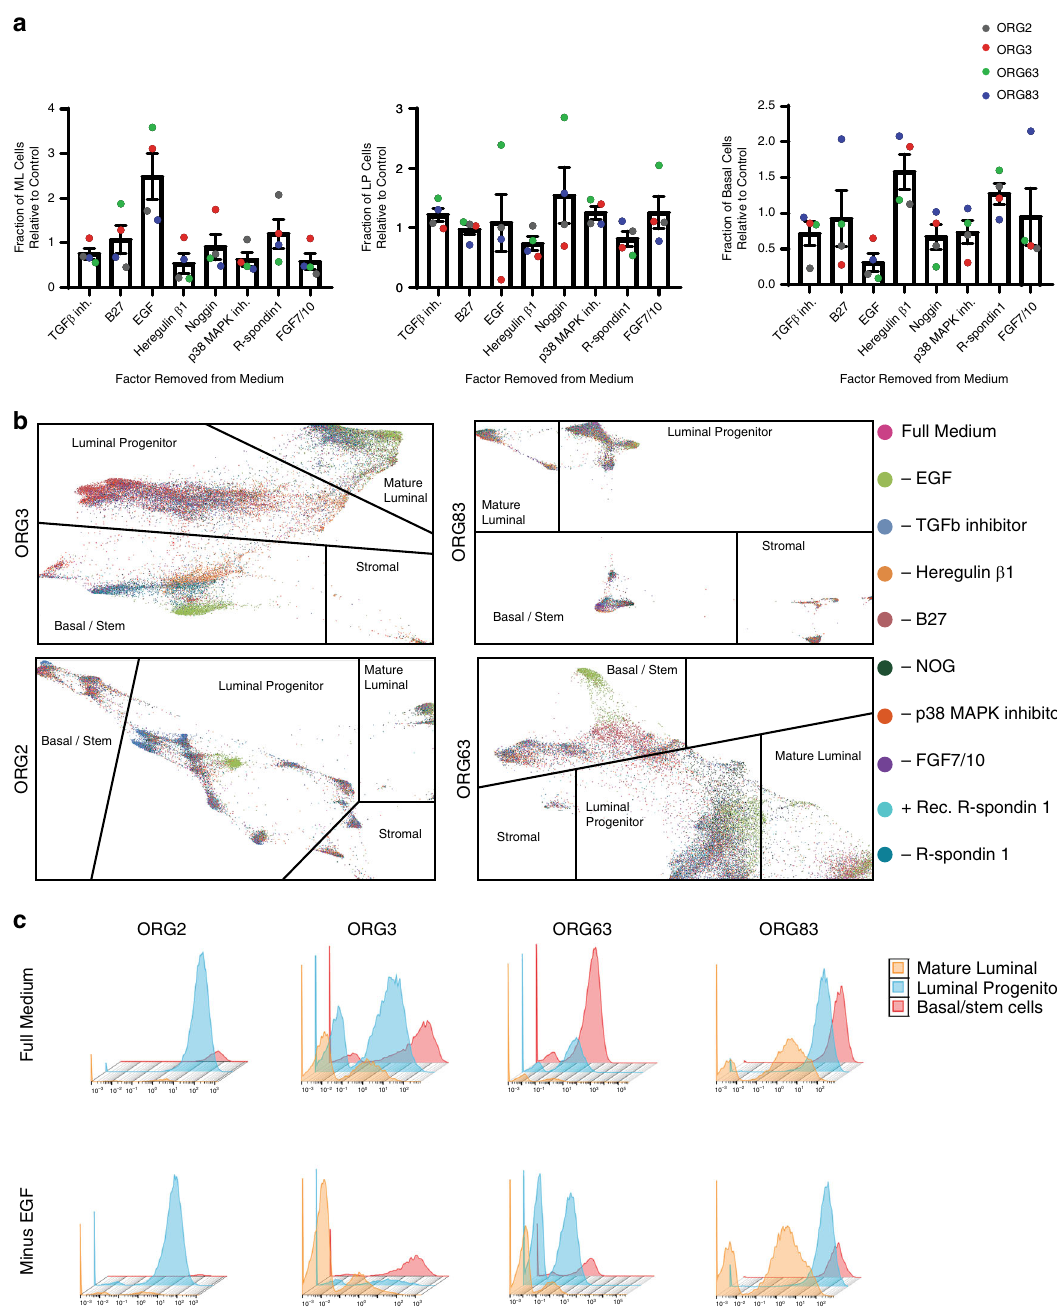
Fig. 8 Distribution of mammary epithelial lineages upon removal of factors from organoid medium. Four human mammary tissues were dissociated, and a set of ten matching organoid cultures was generated using media formulations each with removal of the indicated medium component. a Fraction of mature luminal (ML), luminal progenitor (LP), and basal cells in organoid cultures grown in medium lacking the indicated factor, as normalized to control (full medium). Mean with standard error of the mean is shown ( n = four cultures). b Force-directed layouts for the four sets of organoid cultures is shown where each dot, representing a single cell, is colored based on the speci fi c formulation of media used. c EGFR expression levels in mature luminal, luminal progenitor, and basal/stem cells is shown by histogram, as measured by CyTOF, in matched organoid cultures grown in the presence or absence of EGF as